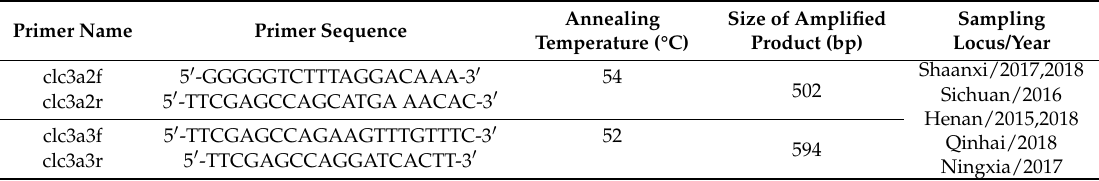
Table 2. Primer sequences for M.